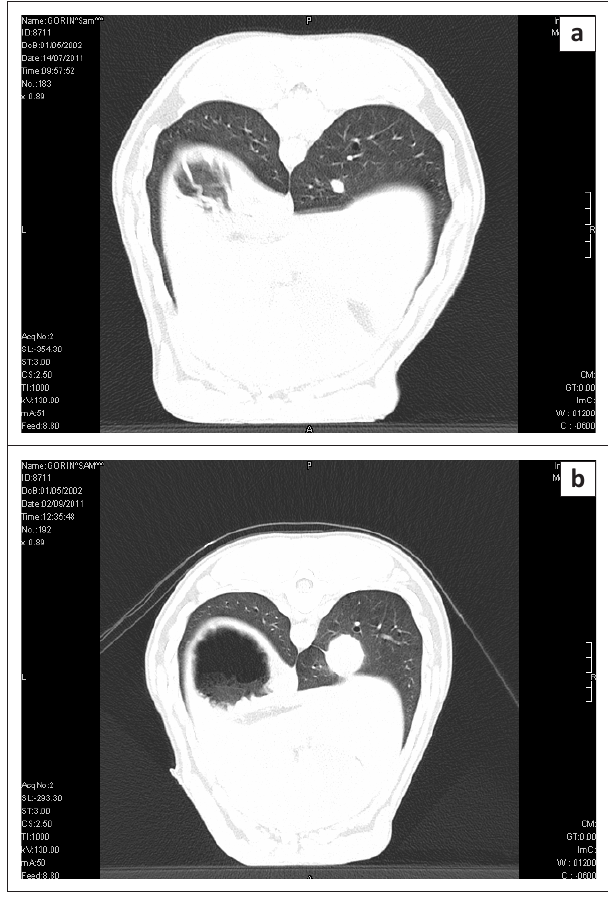
Scan performed using the lung window. FIGURE 7: Computed tomography scan of the thorax, showing progression of the metastatic nodule in the right caudal lung lobe (a) four and (b) six months after